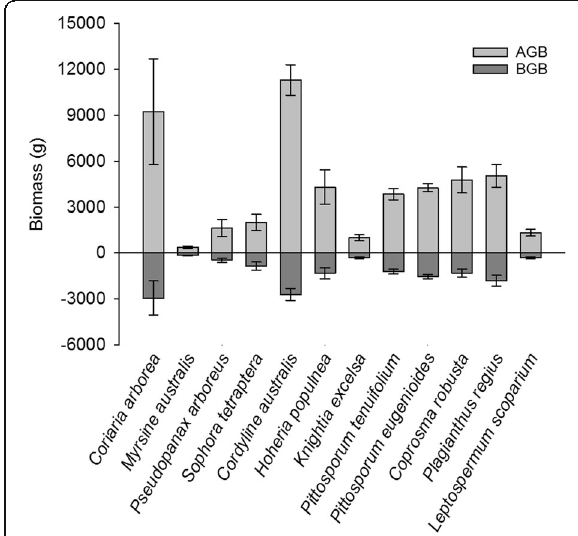
Fig. 2 Plant biomass above- (dark bars) and below-ground (light bars) in year 5. Error bars represent one standard error of the mean. Bars within each parameter with a different letter were significantly different ( P =